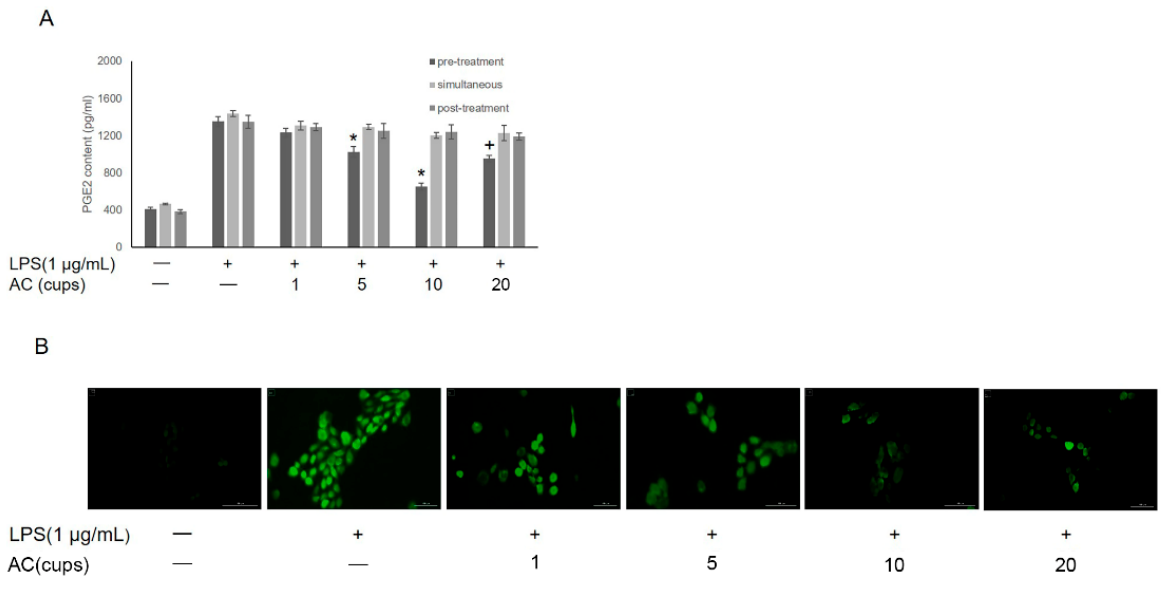
Figure 2. ( A )The released PGE 2 levels in pretreatment, simultaneous, and post-treatment groups were detected under treatment with 0–20 cups AC using the prostaglandin E 2 assay kit. ( B ) The intracellular ROS formation under 0–20 cups AC pretreatment was detected with DCF-DA staining. * p -value < 0.05 vs. LPS treated control; + p -value < 0.05 vs. AC (10 cups). “-” represent untreated group; “+” represent treated with LPS